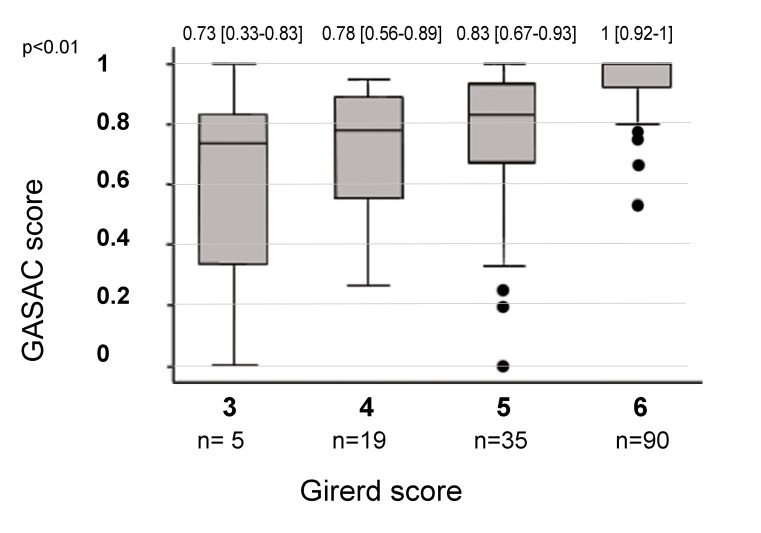
Comparison between GASAC and Girerd adherence scores (n = 149).Box plot representing the results by continuous variables using median and IQR [25th and 75 percentile].